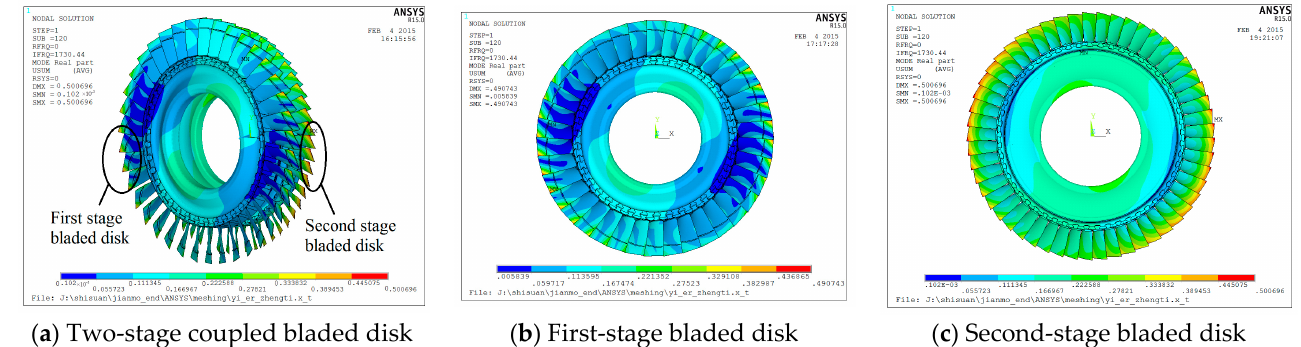
Figure 29. Coupled vibration at a natural frequency of 1730.44 Hz.